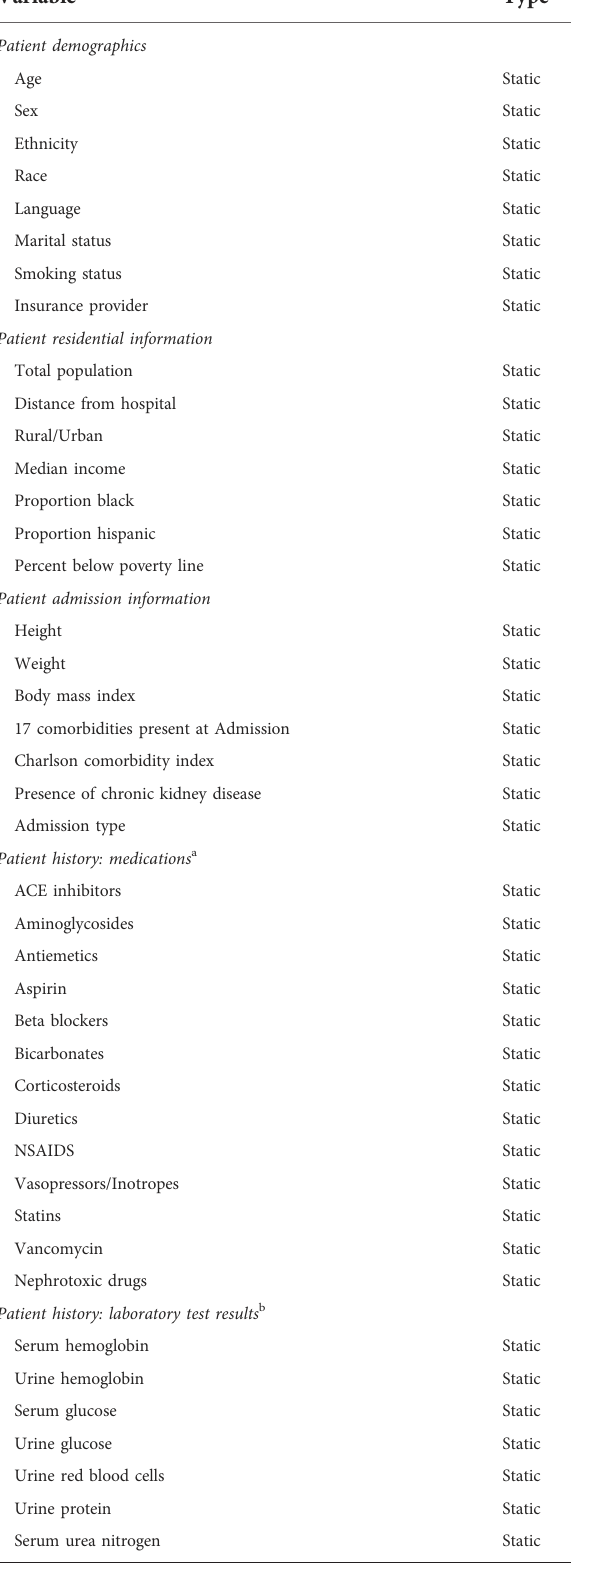
TABLE 2 Summary of variables used in Transformer